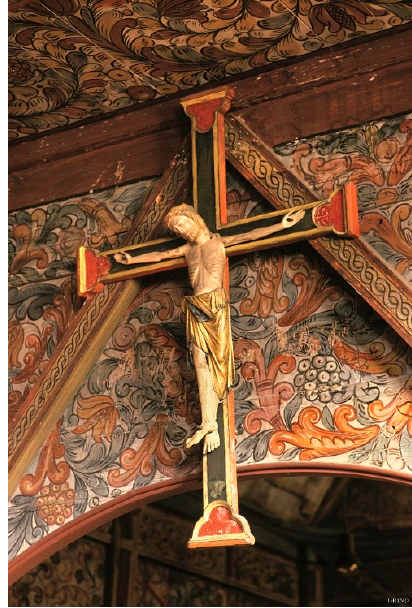
Figure 1. Crucifix from Røldal. Polychrome oak, c.1250. Røldal church. Photo: Svein Nord/Grind.